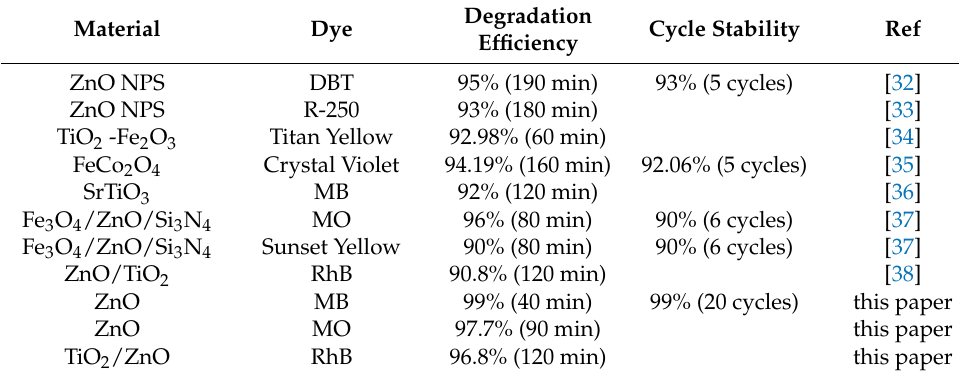
Table 1. Comparison of catalytic performance.